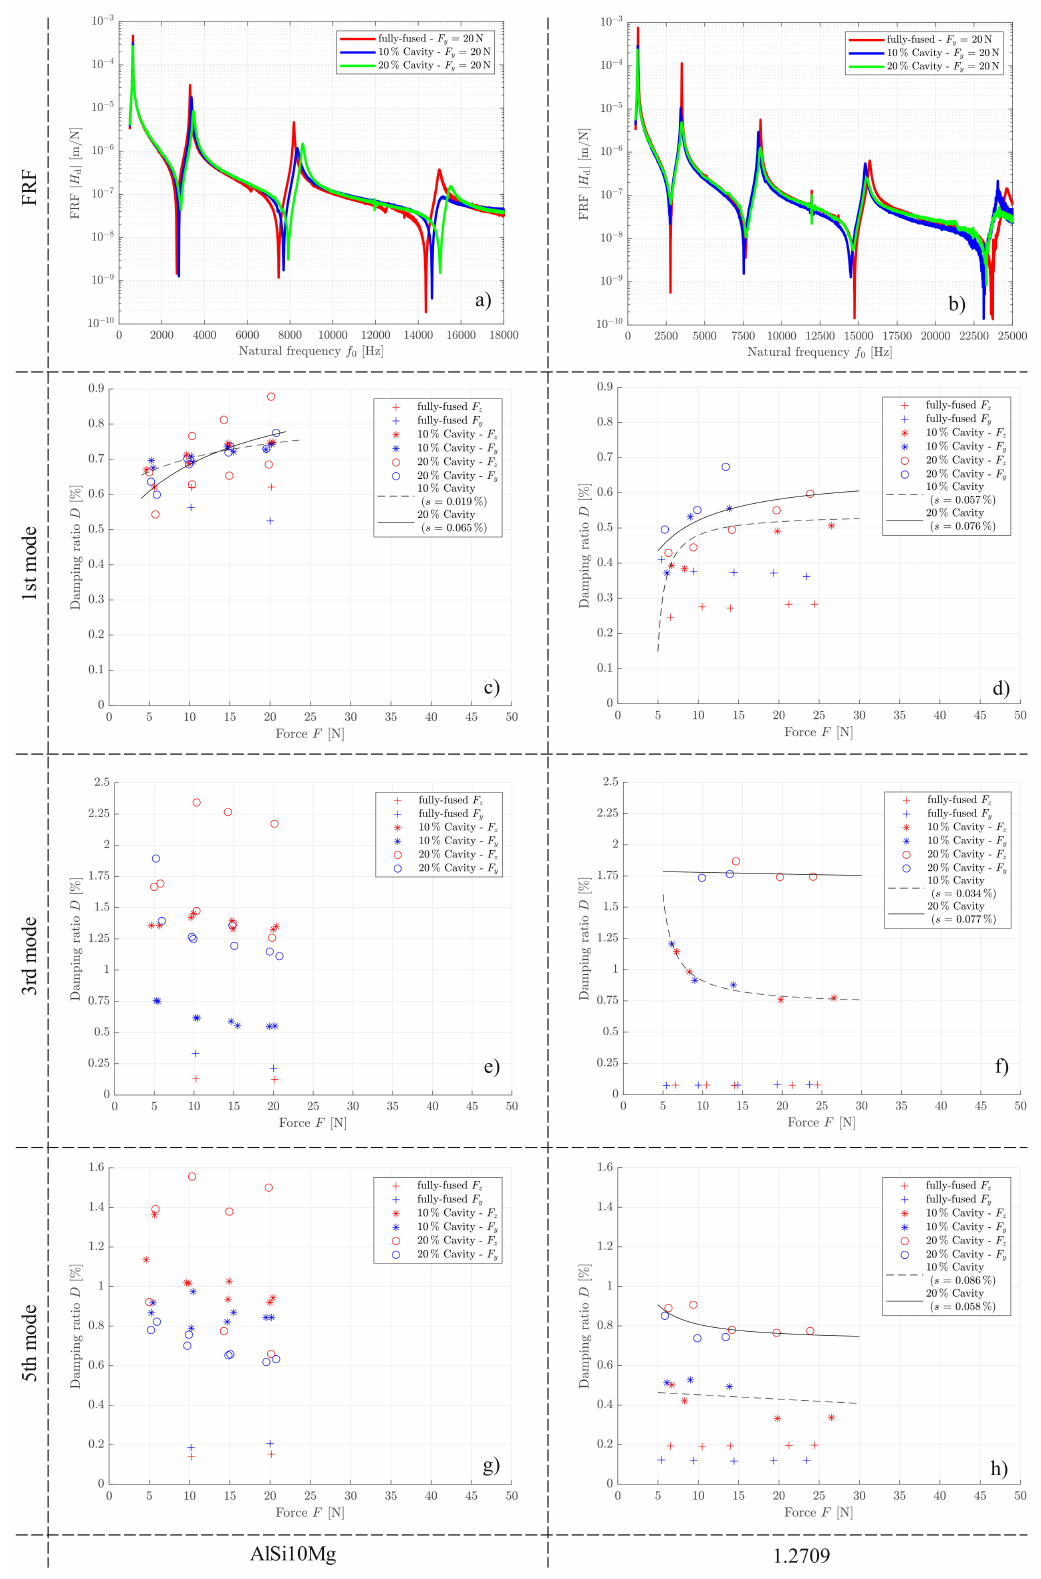
Figure 8. Frequency response functions and force-dependent damping characteristics (1st, 3rd and 5th mode) Left: outer dimensions: 05 × 05 × 200 mm 3 , parameter 15–17, material: AlSi10Mg, right: outer dimensions: 4.2 × 4.2 × 169 mm 3 , parameter 46–48, material: